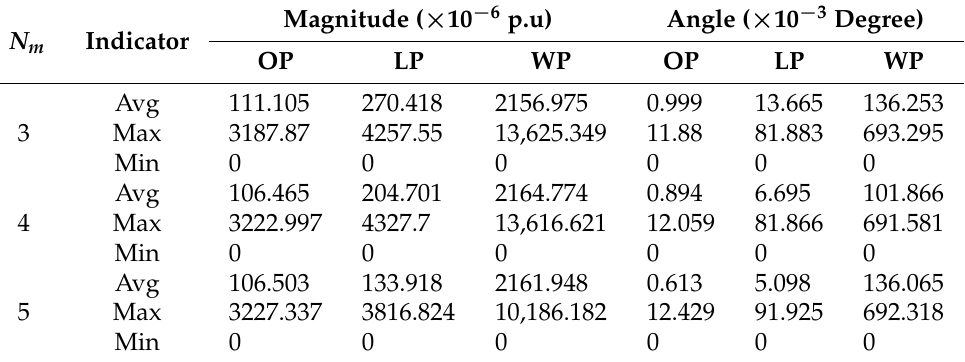
Table 6. State estimation error—69-bus system. Magnitude ( × 10 − 6 N m Indicator